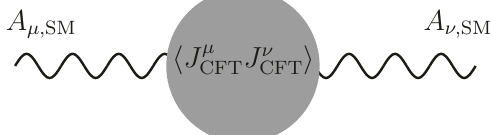
Figure 2 . SM gauge (cid:12)elds dressed by insertion of CFT correlators, equivalent to the e(cid:11)ect of the gauge KK continuum on brane-localized SM